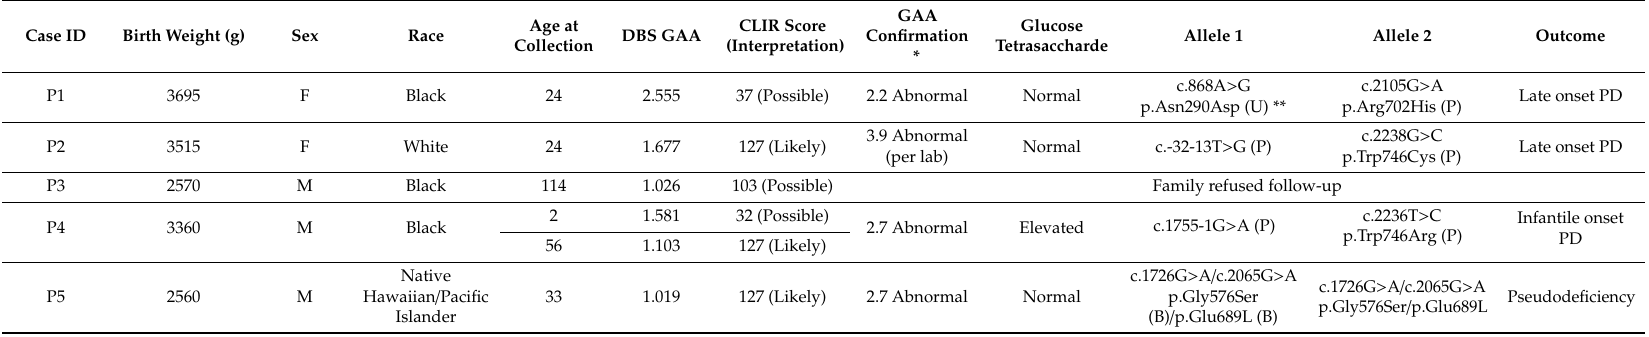
Table 2. Positive screens for PD during Georgia pilot study. Collaborative Laboratory Integrated Reports (CLIR) interpretation possibilities are uninformative (below 1st percentile), possible (1st–5th percentiles), likely (5th–20th percentiles) and very likely ( > 20th percentile). * Enzyme units are pmol / punch / hour. Enzyme interpretations are those reported by the laboratory performing confirmatory analysis. All GAA confirmation results were performed on DBS. Reference range is > 3.88 pmol / punch / hour. Variant interpretations are those received from the clinical laboratory performing testing (B = benign; P = pathogenic; U = variant of uncertain significance). ** Classified as non-pathogenic in Erasmus database in 2012. See discussion in